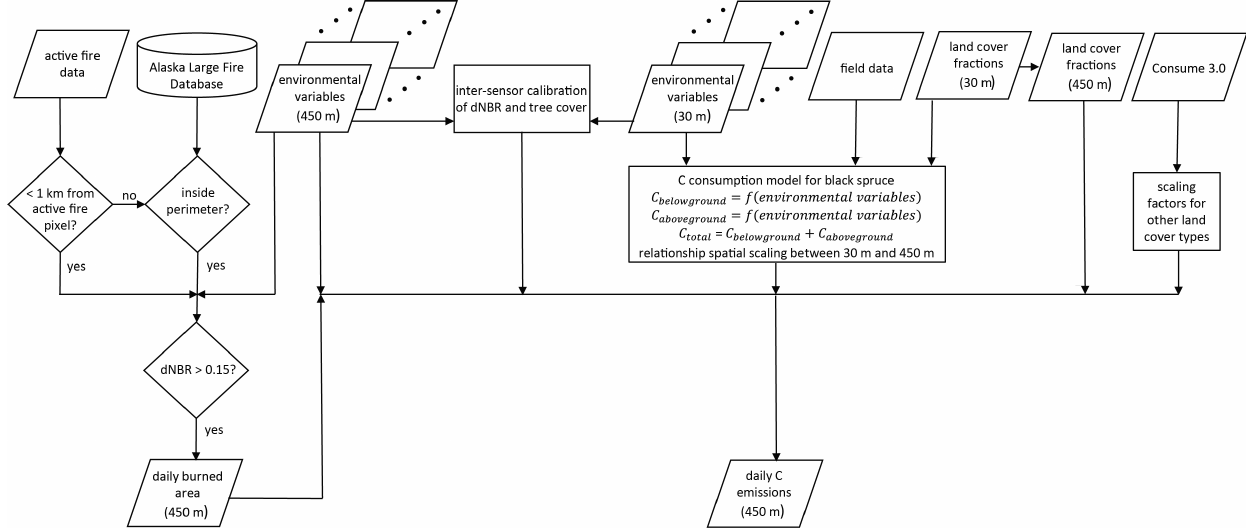
Figure 2. Workflow used to obtain daily burned area and carbon emissions in the Alaskan Fire Emissions Database (AKFED). dNBR: differenced normalized burn